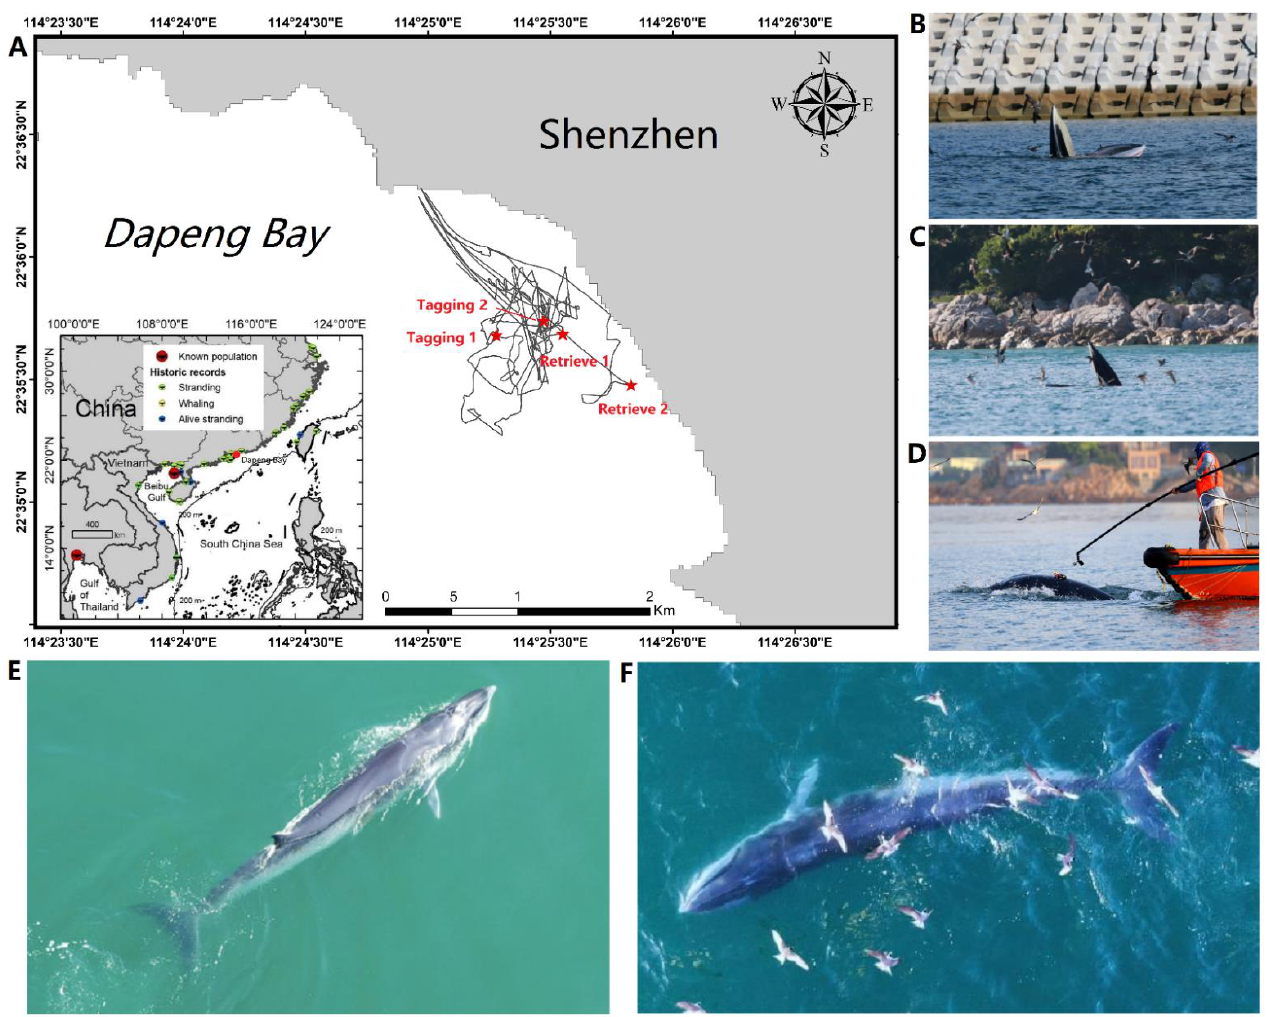
Figure 1. ( A ) A map of the study area. The red stars illustrate the locations where the tag was deployed or retrieved. ‘1′ and ‘2′ represent the first and second successful tagging on July 2 and 4, 2021, respectively. The grey line shows the accumulated speedboat survey routes from 2 – 5 July, indicating the occurrence range of the whale during the investigating period. The geographical relationship of B. e. edeni between the Gulf of Thailand, Beibu Gulf and this study area is illustrated in bottom-left figure (revised from the previous publication [11]). ( B ) and ( C ) The whale performed tread-water feeding (Photo credit: Dr. Wenzhi Lin). ( D ) The tag was deployed on the whale successfully (Photo credit: Ping Bei). ( E ) and ( F ) The full body of the whale (( E ) was adopted from https://appdetail.netwin.cn/web/2021/07/696e84b7804533a89fa39bc511ba516f.html, accessed on 6 September 2022, photo credit: Yuxuan Chen and Yaozhong Liu; ( F ) was adopted from https://finance.southcn.com/node_36f2f52b77/21e9d69d96.shtml, accessed on 6 September 2022, photo credit: Lei Shi).